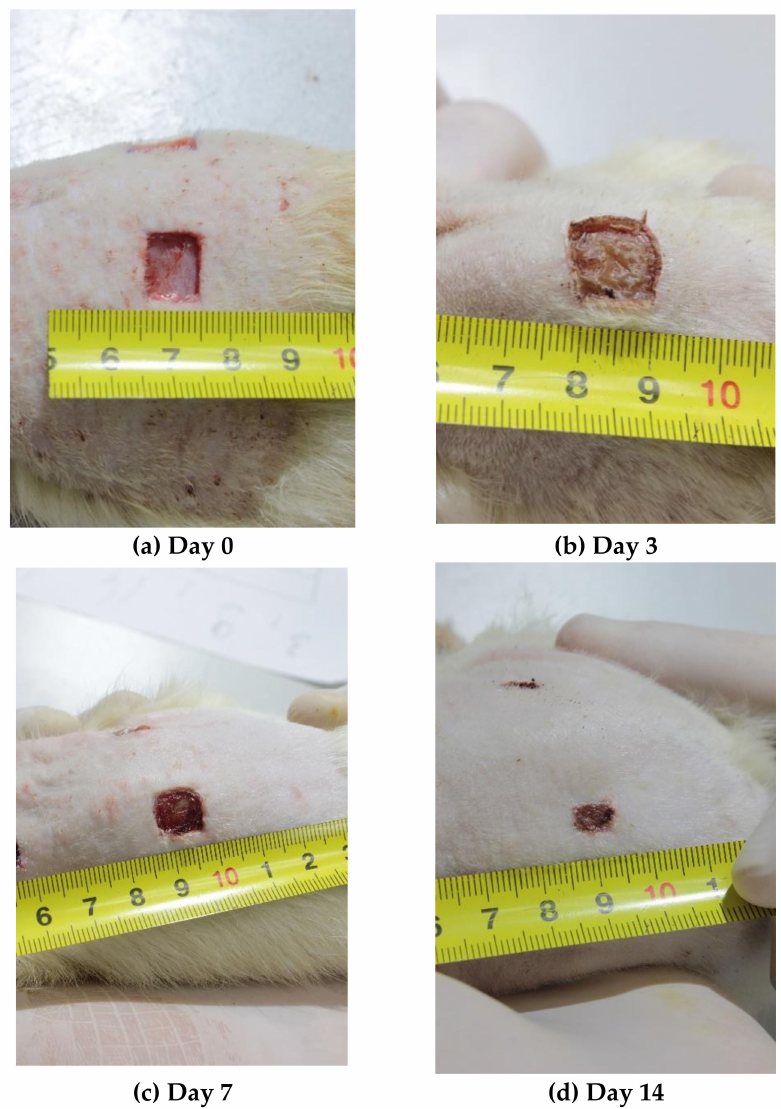
Figure 1. Photographs of the wounds over time (Days 0, 3, 7,